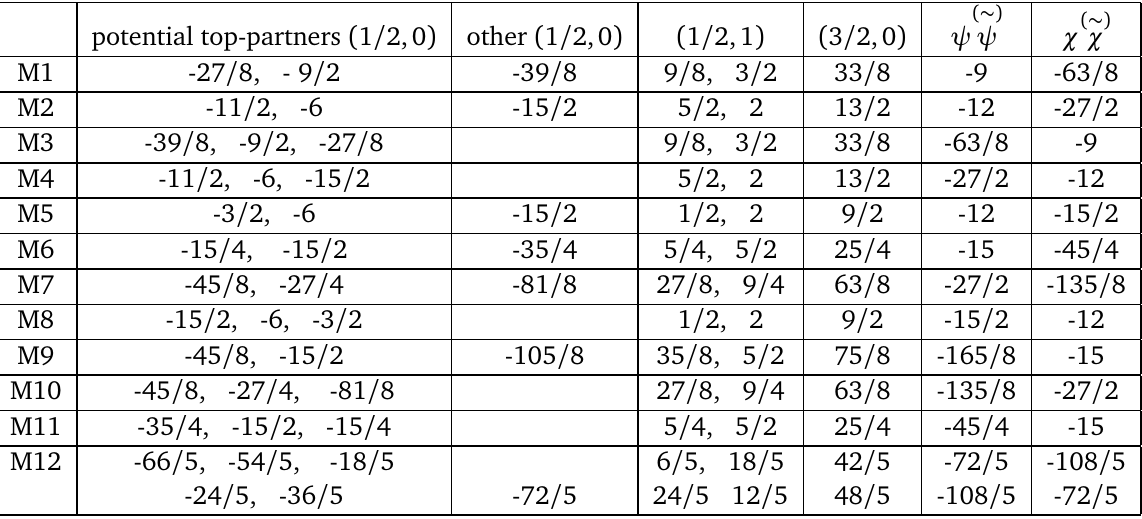
Table 2: Coefficient A of the γ -function according to eq.